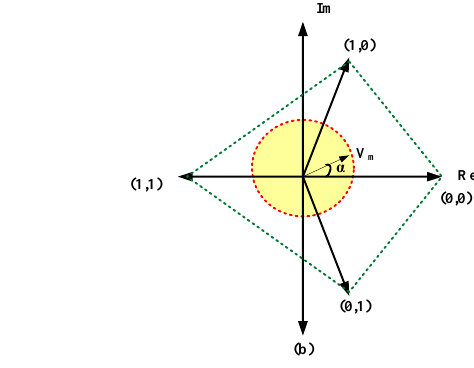
Figure 7. Space vector diagram for (a)V dc1 = V dc2 (b) V dc1 ≠ V dc2